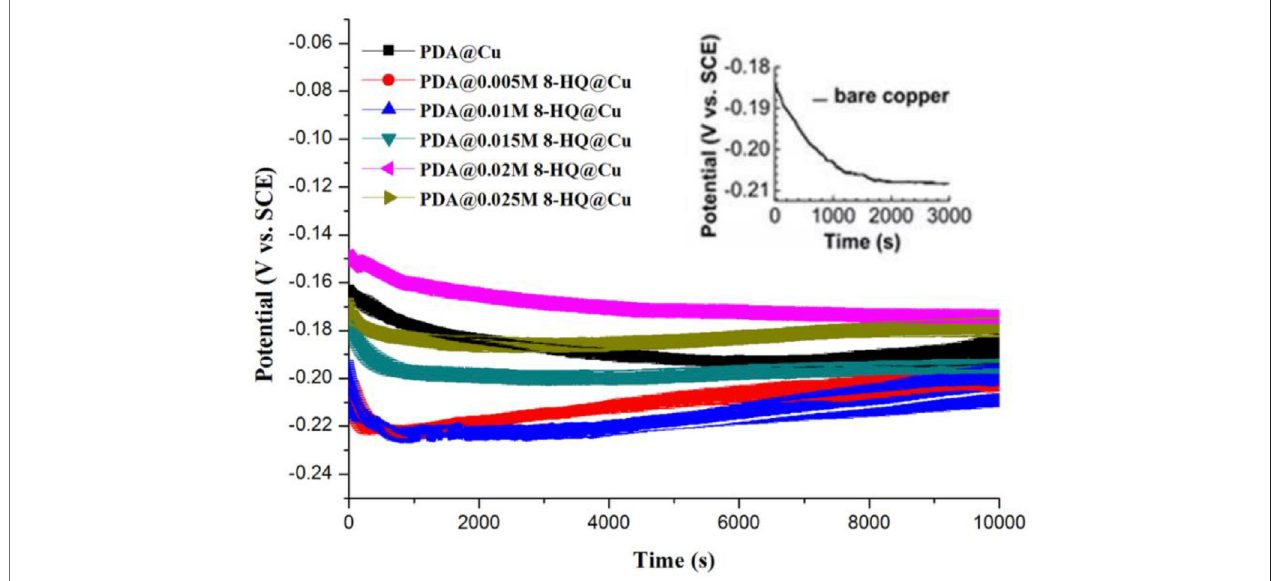
FIGURE 3 | Open circuit potential versus time of different copper samples recorded in 3.5 wt.% NaCl aqueous solution (The error means a standard deviation of three measurements. OCPs ofbare Cu,PDA@Cu,and concentrationof8-HQin0.005 M,0.01 M,0.015 M, 0.02 M, and0.025 Mare − 0.209±0.003, − 0.196±0.002, − 0.202 ± 0.004, − 0.198 ± 0.003, − 0.191 ± 0.003, − 0.172 ± 0.002, and − 0.187 ± 0.001 mV (vs. Ag/AgCl, 3 M KCl),